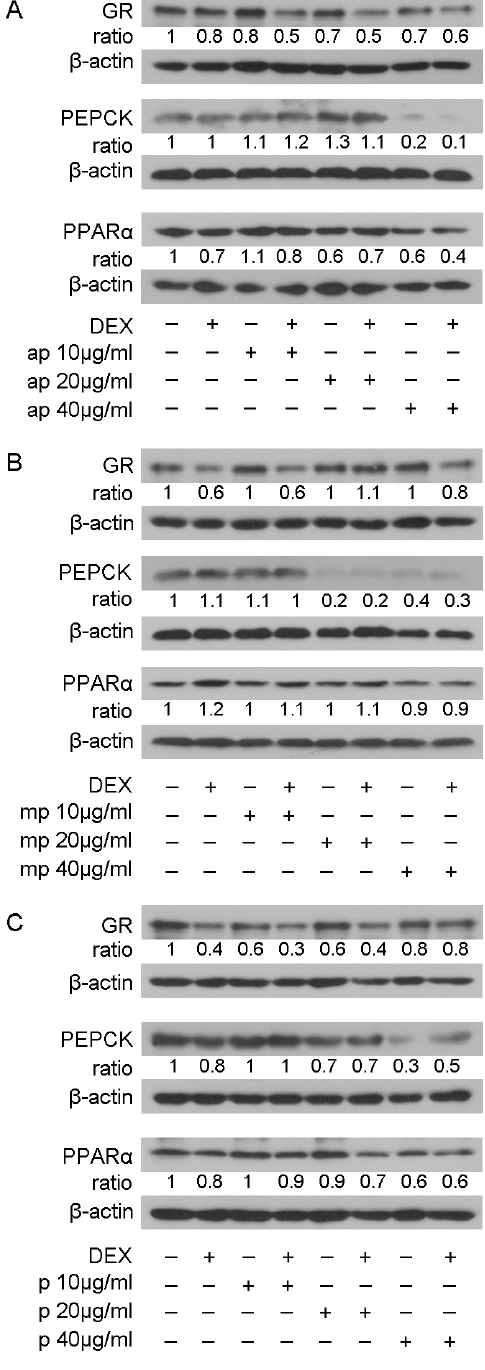
Figure 4. Regulation of GR, PEPCK, and PPAR α protein levels by Chios Mastiha different polarity fractions. Representative images from Western blot analysis of GR, PEPCK, and PPAR α from HEK293 cell extracts precultured in hormone-free medium for 48 h and subsequently treated with 10, 20, and 40 µg/mL of apolar ( A ), medium-polar ( B ), and polar ( C ) fractions for 48 h. Ratios result from normalization of GR, PEPCK, and PPAR α bands intensity to the respective β -actin ones. Relative protein levels in control cells were set as 1.